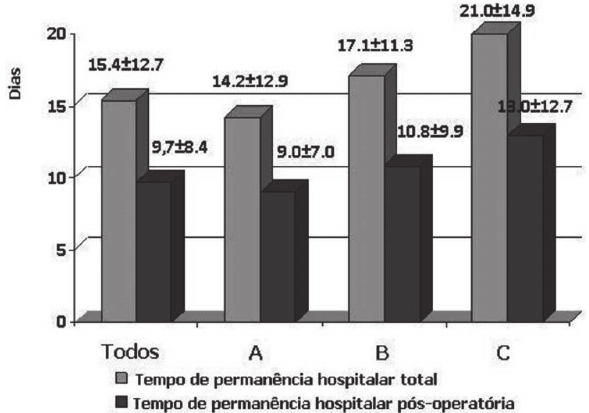
Fig. 4 - Pacientes dos grupos B e C apresentaram TPHT e TPHPO significativamente maiores do que os do grupo A P <0,05; teste